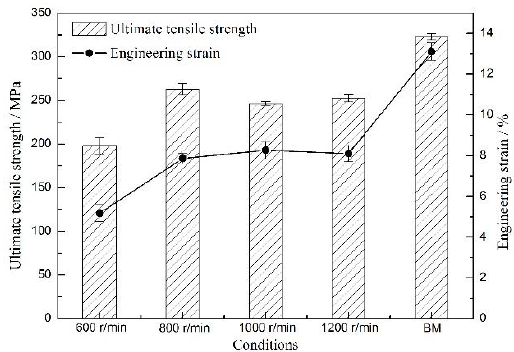
Figure 11. Tensile properties of the joints at different rotational speeds.